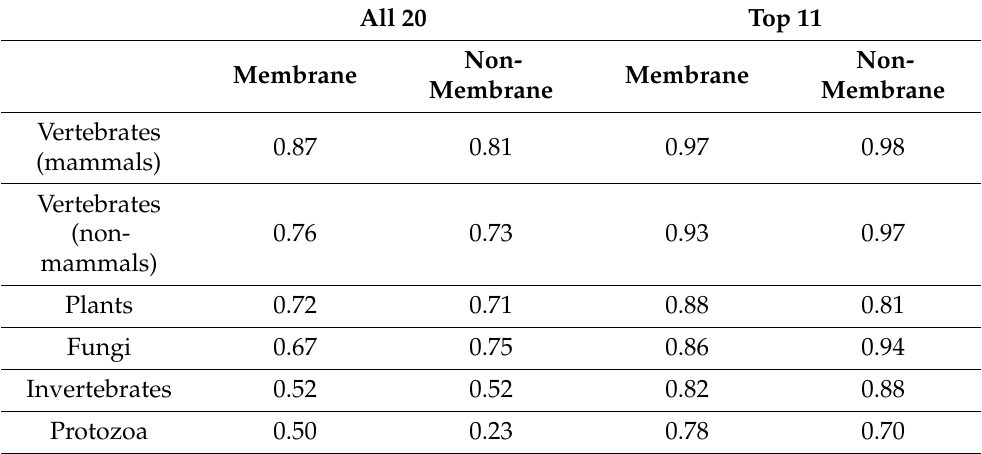
Table 1. Pearson correlation r between amino acid frequencies and codon multiplicities.